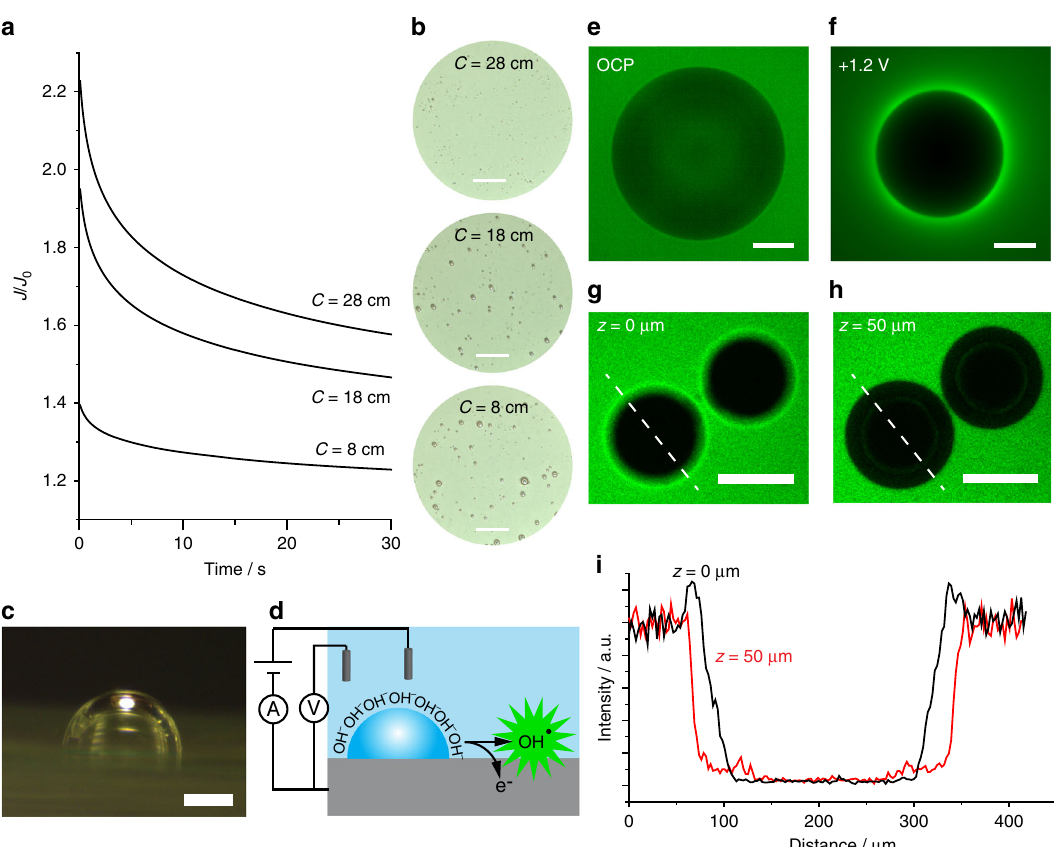
Fig. 1 Surface-adherent gas bubbles increase electrochemical current outputs. a Normalized amperometric curves acquired in aqueous 0.1 M sodium hydroxide using an ITO electrode, biased at + 1.2 V vs. SHE, in the presence of surface-adherent oxygen cavities. The current density recorded in the presence of surface-adherent bubbles ( J ) is systematically higher than that found in the absence of bubbles ( J 0 ). The experimental J / J 0 ratio scales with the total bubble corona length (C, data analysis in Supplementary Fig. 2, and Supplementary Table 1). b Optical images of the ITO electrode acquired during the current measurements reported in ( a ). Scale bars are 2 mm. Wide- fi eld views of the entire electrode area are in Supplementary Fig. 2. c Representative bright- fi eld image (side view) of an oxygen bubble on the ITO electrode. The scale bar is 200 µ m. d Schematics of the electrochemical generation, and fl uorescence detection, of HO • in the corona of an electrode-adherent bubble. e , f Epi fl uorescence microscopy images for the detection of HO • around an argon bubble adhering on an ITO electrode. The electrode is immersed in an aqueous solution of sodium hydroxide (0.1 M) and 3 ʹ -(p-hydroxyphenyl)